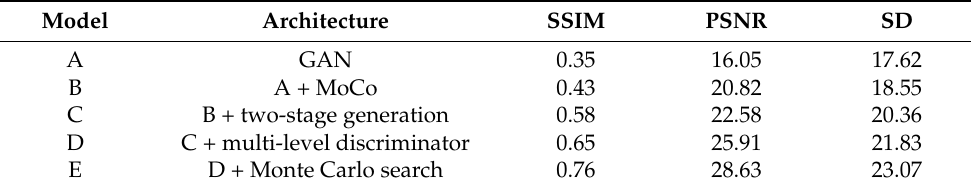
Table 11. Results of ablation